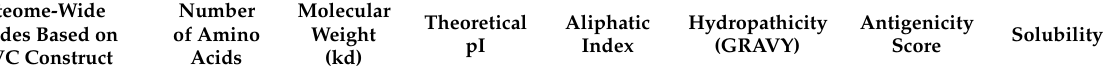
Table 3. Vaccine constructs and their physiochemical properties are predicted using ProtParam, VaxiJen, AllerTop, ToxinPred, and